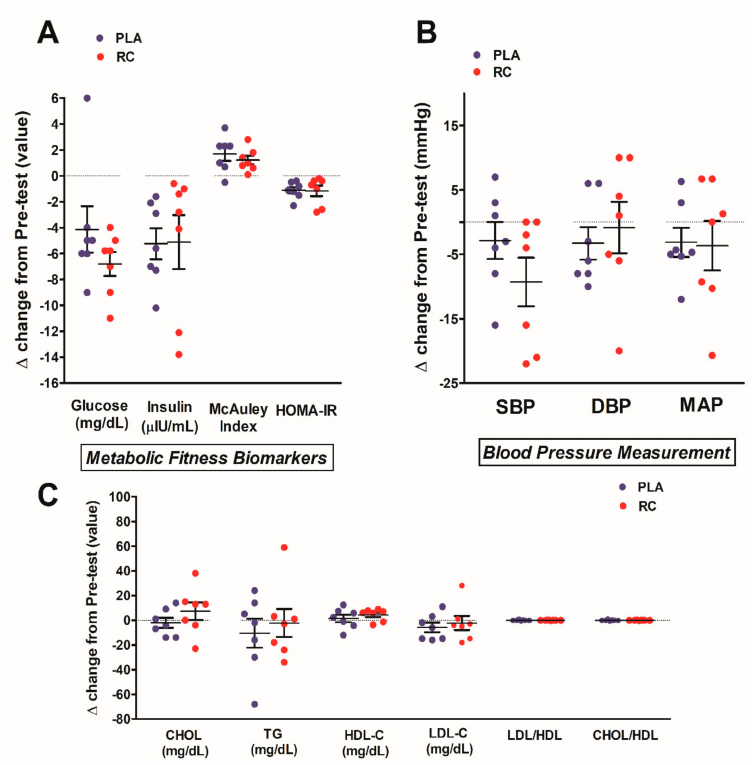
Figure 4. Changes in the metabolic parameters between the placebo and RC groups following eight weeks of intervention. No difference in the glucose metabolism ( A ), blood pressure ( B ), and lipid profile ( C ) changes in both groups after treatment. Blue solid circle: placebo (PLA); Red solid circle: RC supplementation (RC). SBP: Systolic blood pressure, DBP: Diastolic blood pressure. MAP: Mean arterial pressure. CHOL: Cholesterol, TG: Triglyceride, HDL-C: High-density lipoprotein cholesterol, LDL-C: Low-density lipoprotein cholesterol, LDL / HDL: LDL-C to HDL-C ratio. Values are expressed as the mean ±